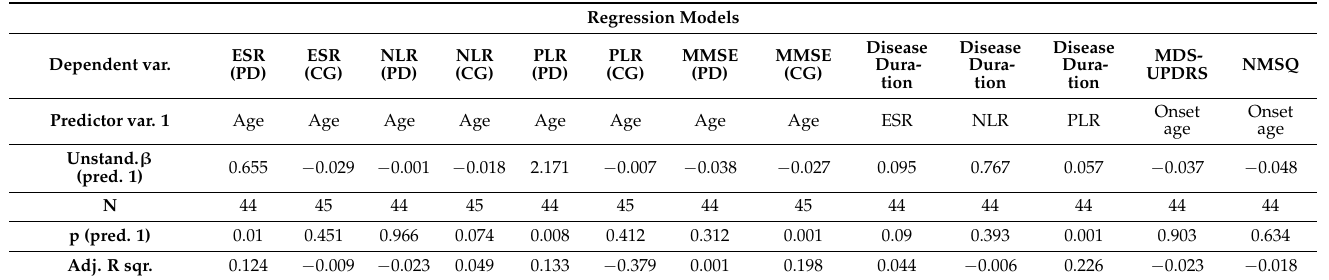
Table 4. Linear regression models utilized to assess the prediction influence between the different clinical and serological parameters, in both the Parkinson and control patients. Regression